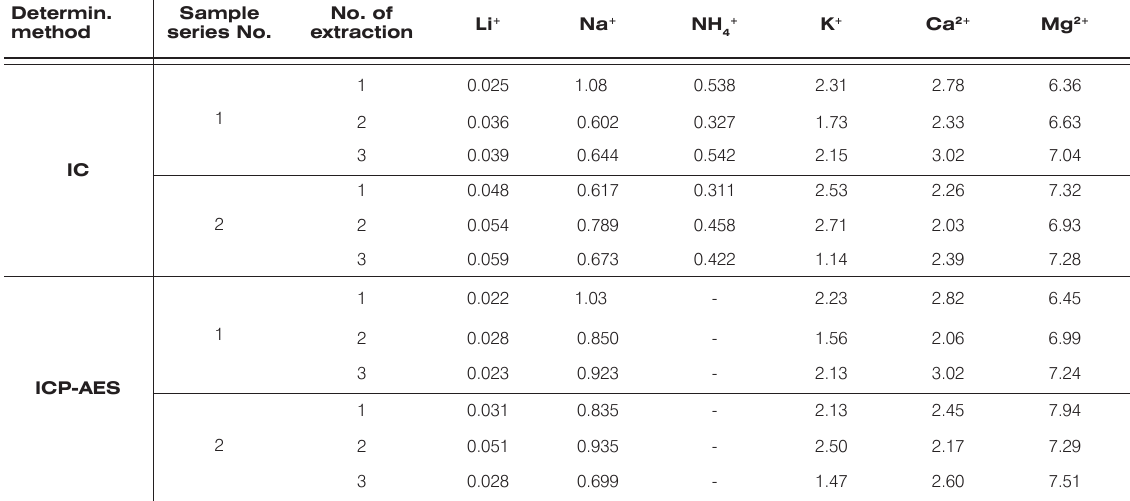
Table 4. The results of determinations of Li + , Na + , NH 4+ , K + , Ca 2+ and Mg 2+ ions obtained by IC and ICP-AES after RAE (mg/100 g soil). Determin. Sample method series No.